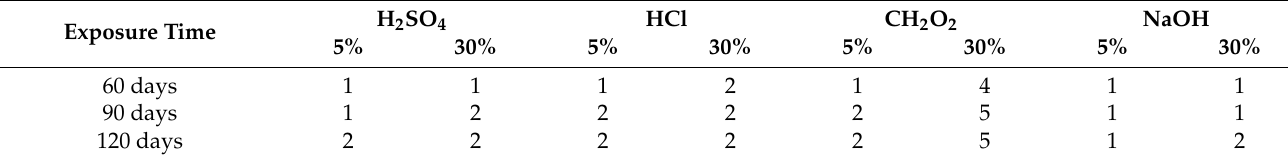
Table 6. Evaluation of the visual assessment of the chemical resistance of the NBR-REF